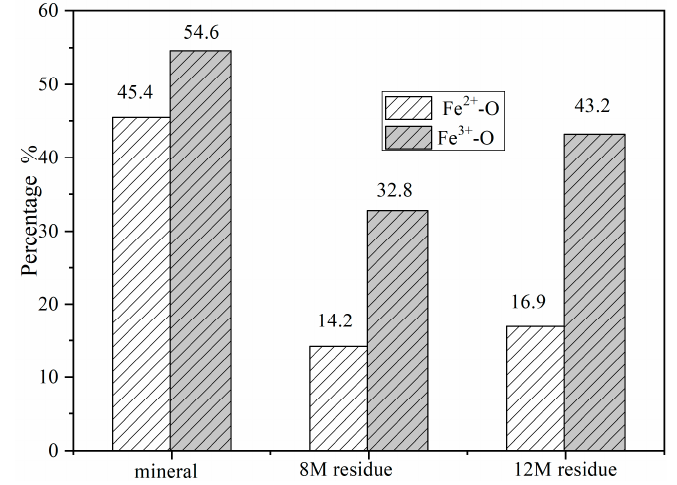
Figure 2. The ratio of Fe 2+ /Fe 3+ on columbite-(Fe) and residues surface. Changes in the Fe 2+ /Fe 3+ ratios in the active regions are a consequence of oxidation dissolution on columbite-(Fe) surface shifts caused by the interaction between the surface chemical ion and the concentration of the H 2 SO 4 acid leaching medium. The Fe 2+ /Fe 3+ ratio on the mineral surface measured from XPS was 0.83, data which demonstrated the ability of XPS to resolve redox-active regions spatially under operating conditions by oxidation leaching. The ratio Fe 2+ /Fe 3+ that shifted on the surface suggested that the reacted rates changed with leaching contents by the surface reaction and electron transport. Figure 3 shows the Fe 2+ -O/Fe 3+ -O ratio and Fe 2+ -SO 4 /Fe 3+ -SO 4 ratio of columbite-(Fe) and residues. The ratio of Fe 2+ -O/Fe 3+ -O on the 8 M H 2 SO 4 acid leaching residue surface was 0.55 which was 0.28 lower than the ratio of the initial mineral. The Fe 2+ -O on the residue surface de- creasing meant Fe 2+ -O was broken and dissolved into the acid medium. The ratio of Fe 2+ - SO 4 /Fe 3+ -SO 4 on the 8 M H 2 SO 4 acid leaching residue surface was 0.66. The ratio of Fe 2+ - O/Fe 3+ -O on the 12 M H 2 SO 4 acid leaching residue was 0.50, which was 0.33 lower than that of the initial mineral, and the ratio of Fe 2+ -SO 4 /Fe 3+ -SO 4 on the surface was 0.71. The decreasing Fe 2+ -O/Fe 3+ -O ratio deduced that this increase in Fe 2+ content meant the im- provement in mineral surface dissolution. It could be due to the ability of the Fe 2+ ions to react with the H 2 SO 4 acid more e ff ectively than with the Fe 3+ ions.